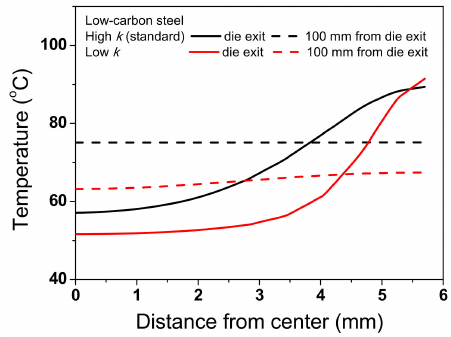
Figure 14. Comparison of temperature profiles along the radial direction of low-carbon steel at die exit and 100 mm from die exit with different thermal